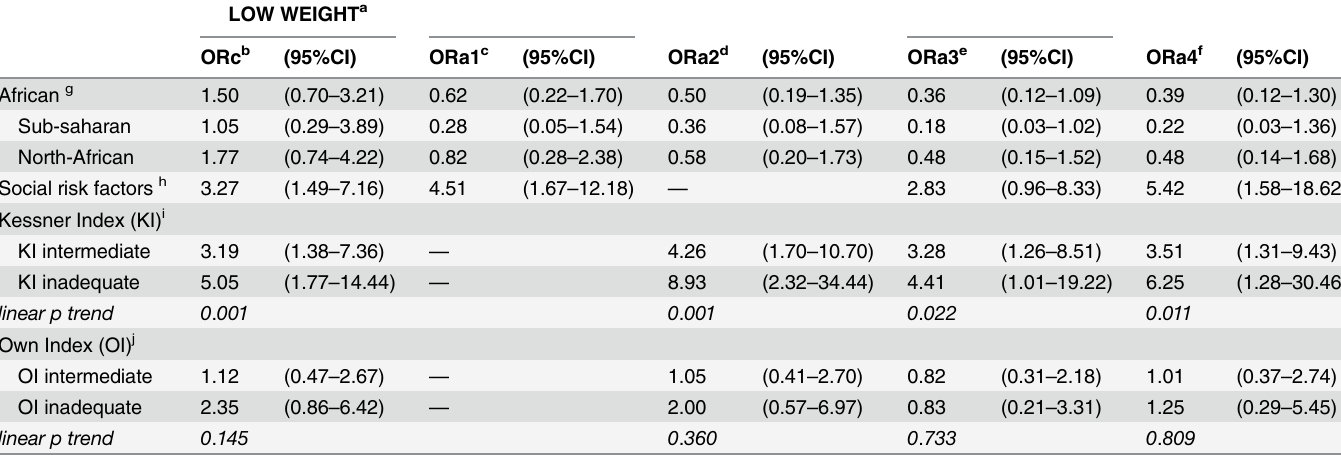
Table 3. Crude and adjusted associations between the immigrant status, other predefined variables (social risk factors and compliance with pre- natal care), and the risk of neonatal morbidity (low weight). Cantabria (Spain): African immigrants and Spanish women 2007 –